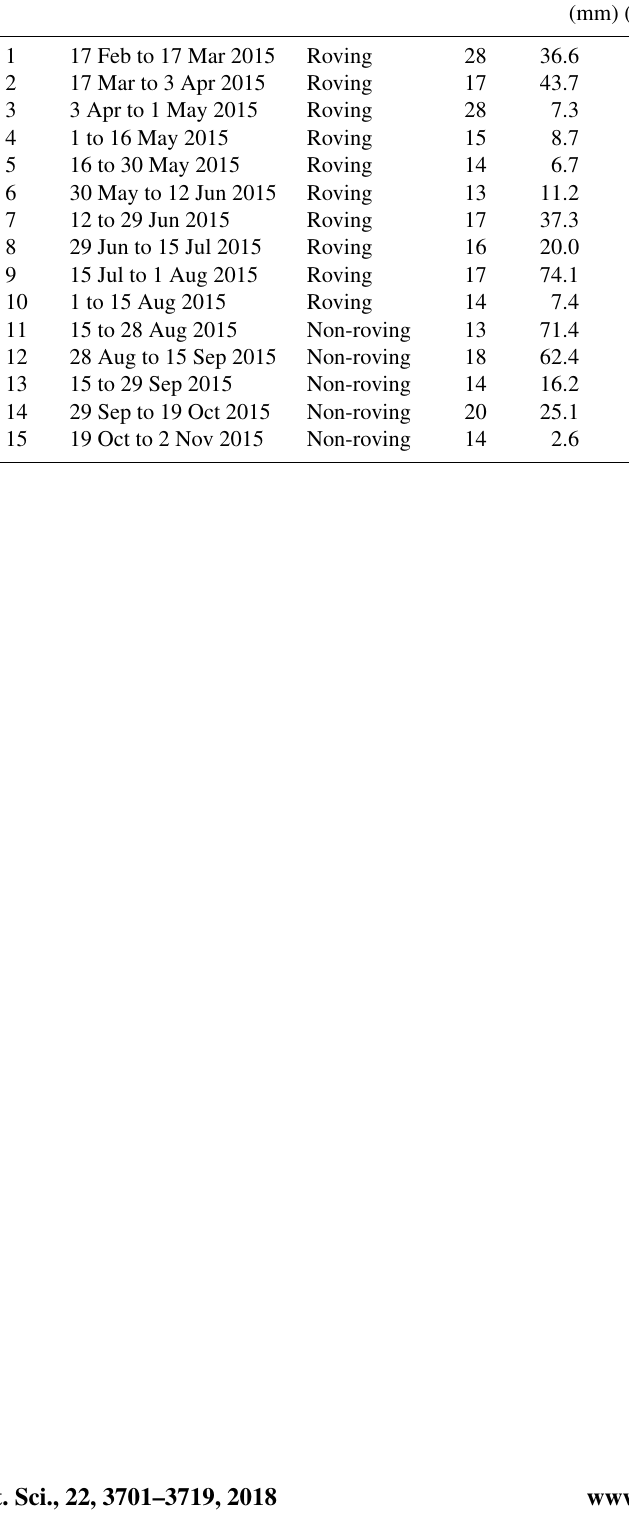
Table A1. Statistical description of collection periods of throughfall and average amounts for a sample size n = 32.